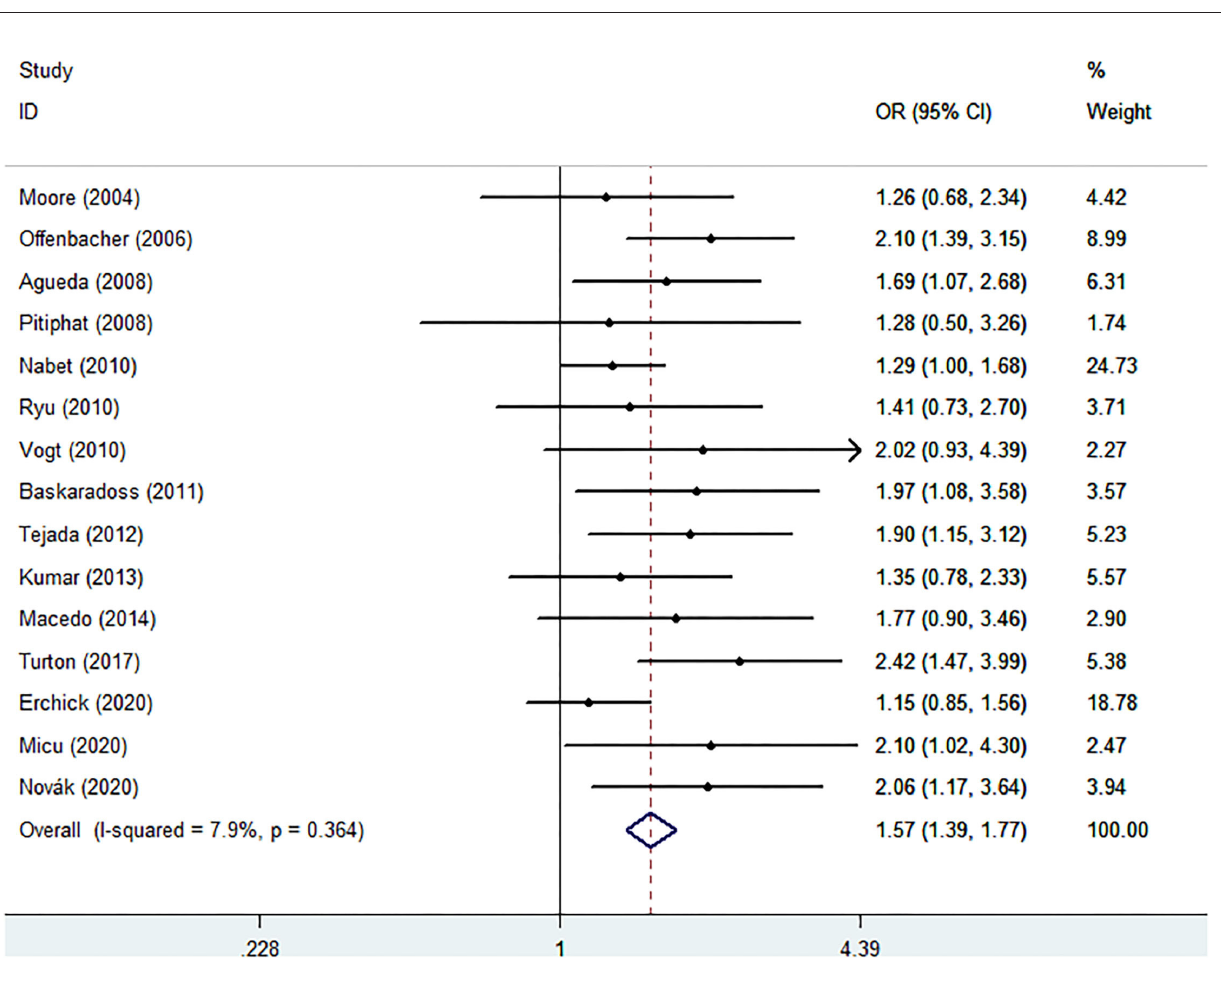
FIGURE 2 | Forest plot of preterm birth